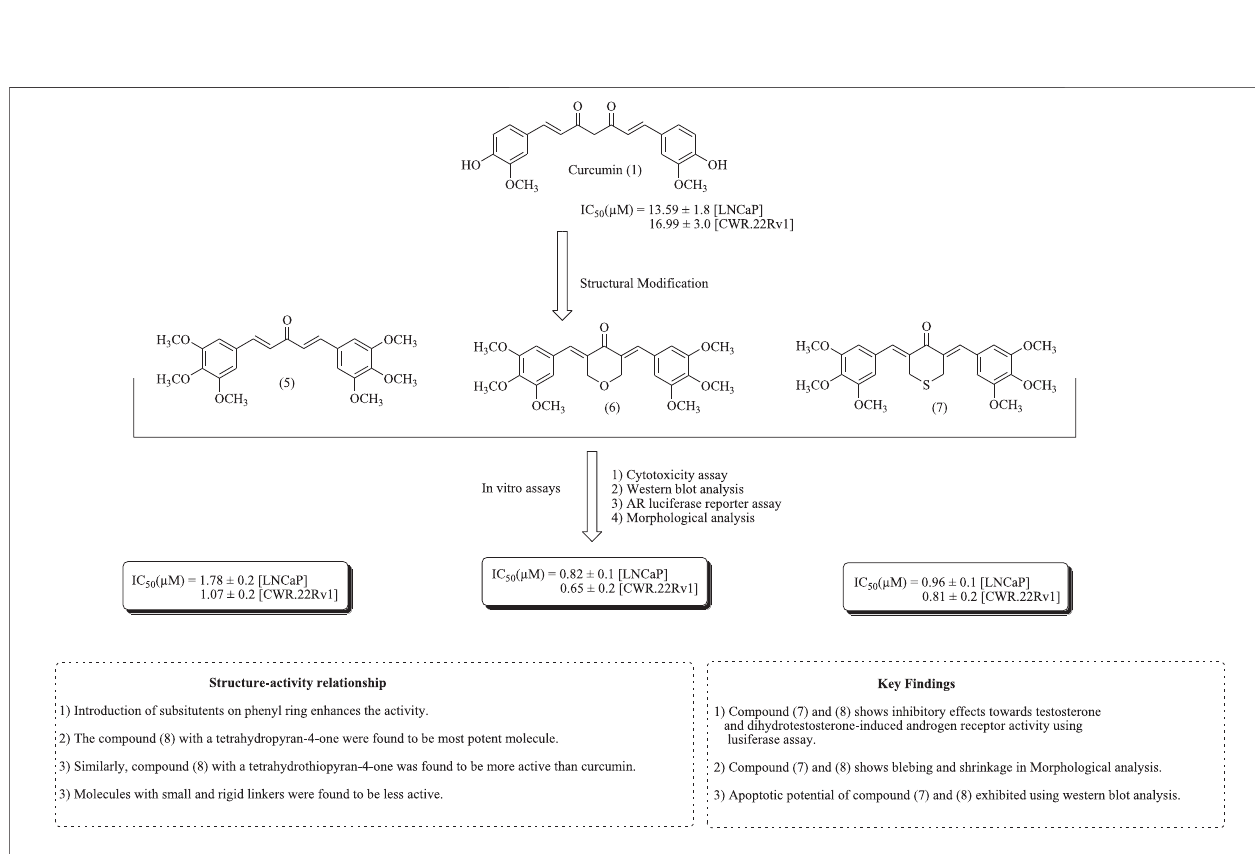
FIGURE 5 | Structure of curcumin and its analogs (5 – 7) along with structure – activity relationships and mechanistic insights.